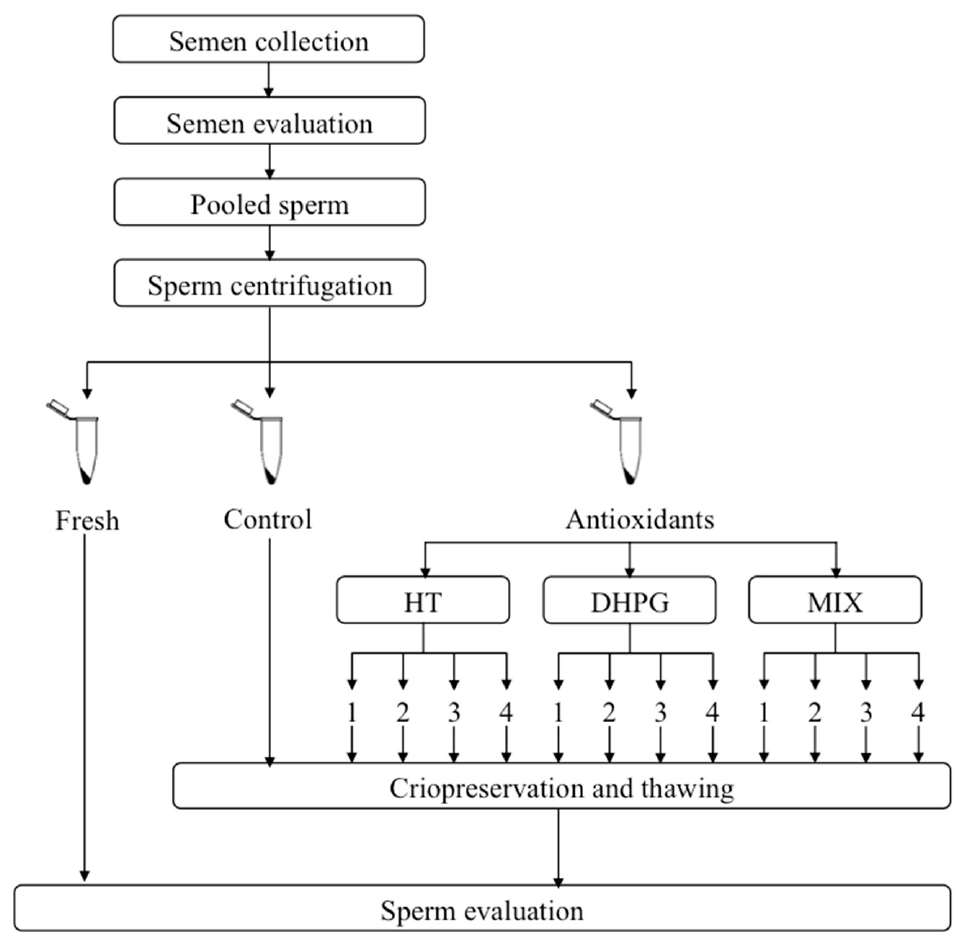
Figure 2. Schematic overview of the experimental design. Sperm motility, viability, acrosome integrity, mitochondrial membrane potential (HMMP), and membrane lipid peroxidation (LPO) were assessed in frozen-thawed sperm samples. Twelve repetitions of the experiment were